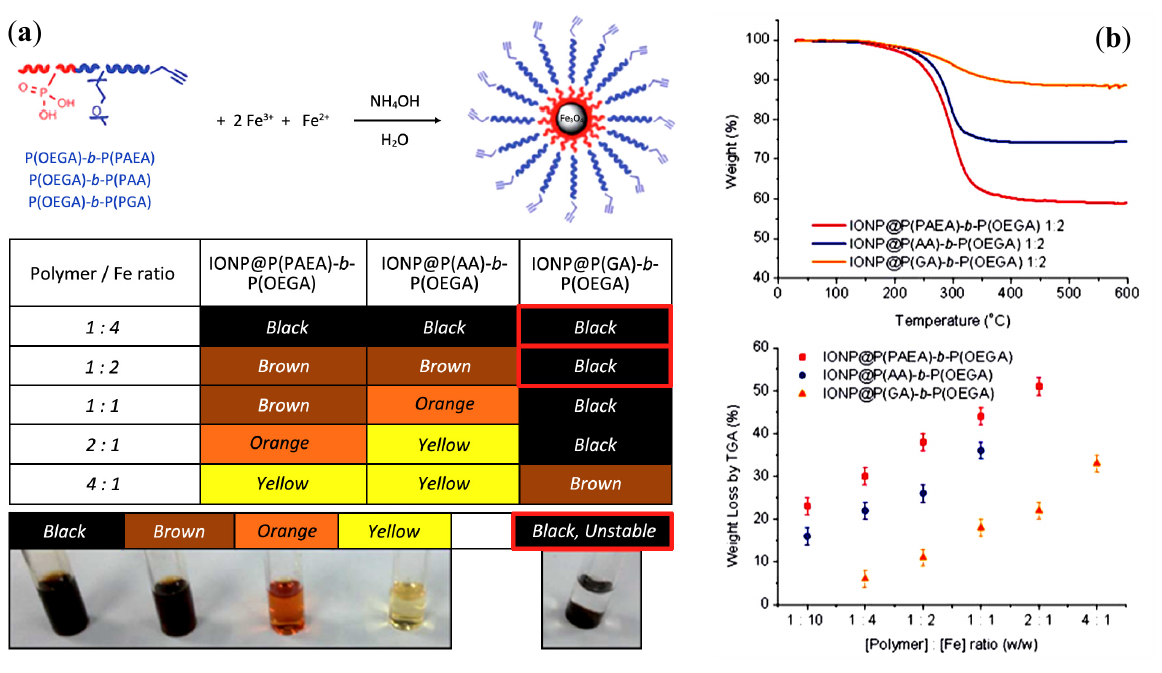
and d ) of TEM XRD